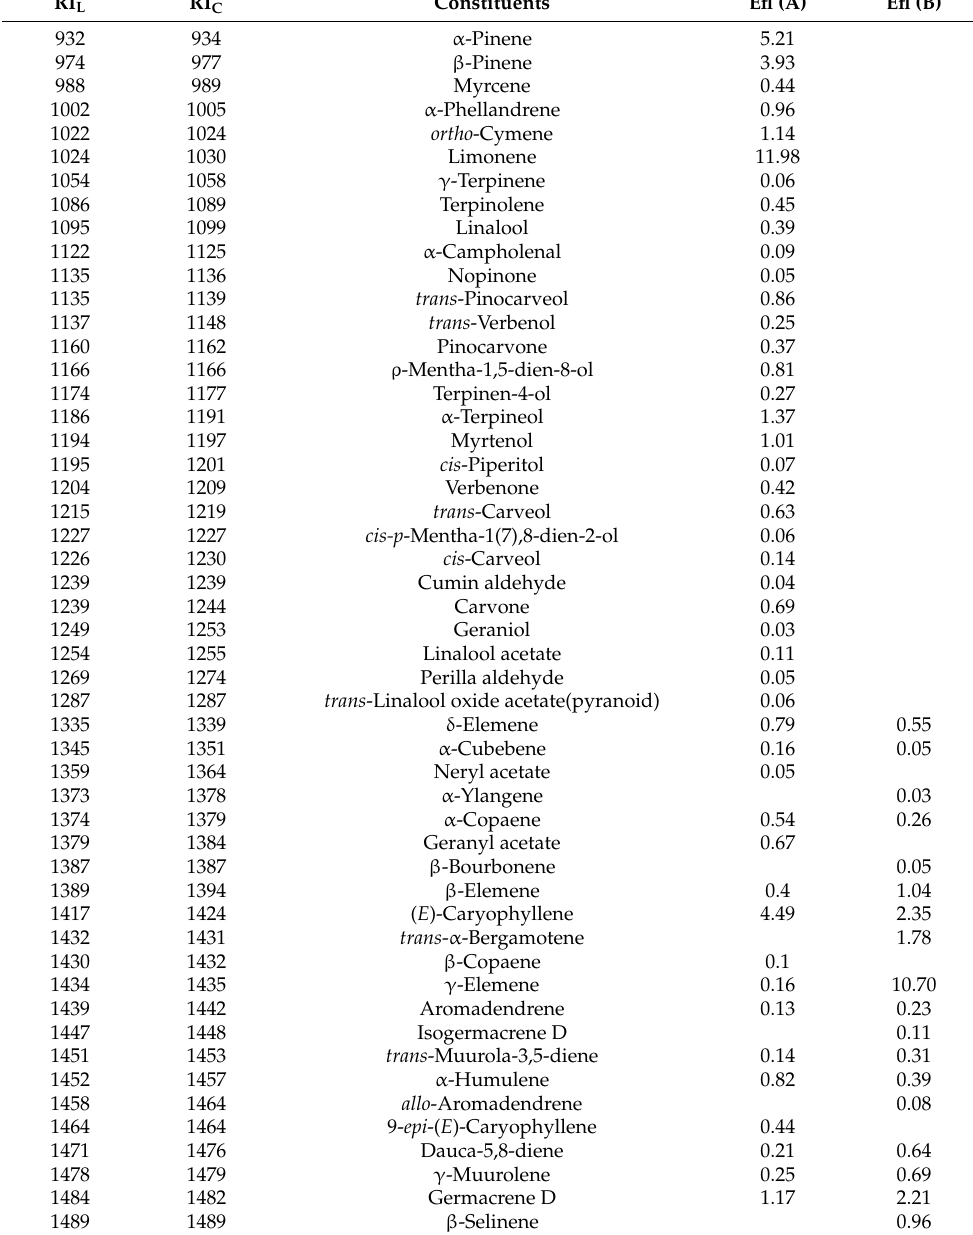
Table 1. Chemical composition of essential oils extracted from Eugenia florida leaves by hydrodistillation. RI